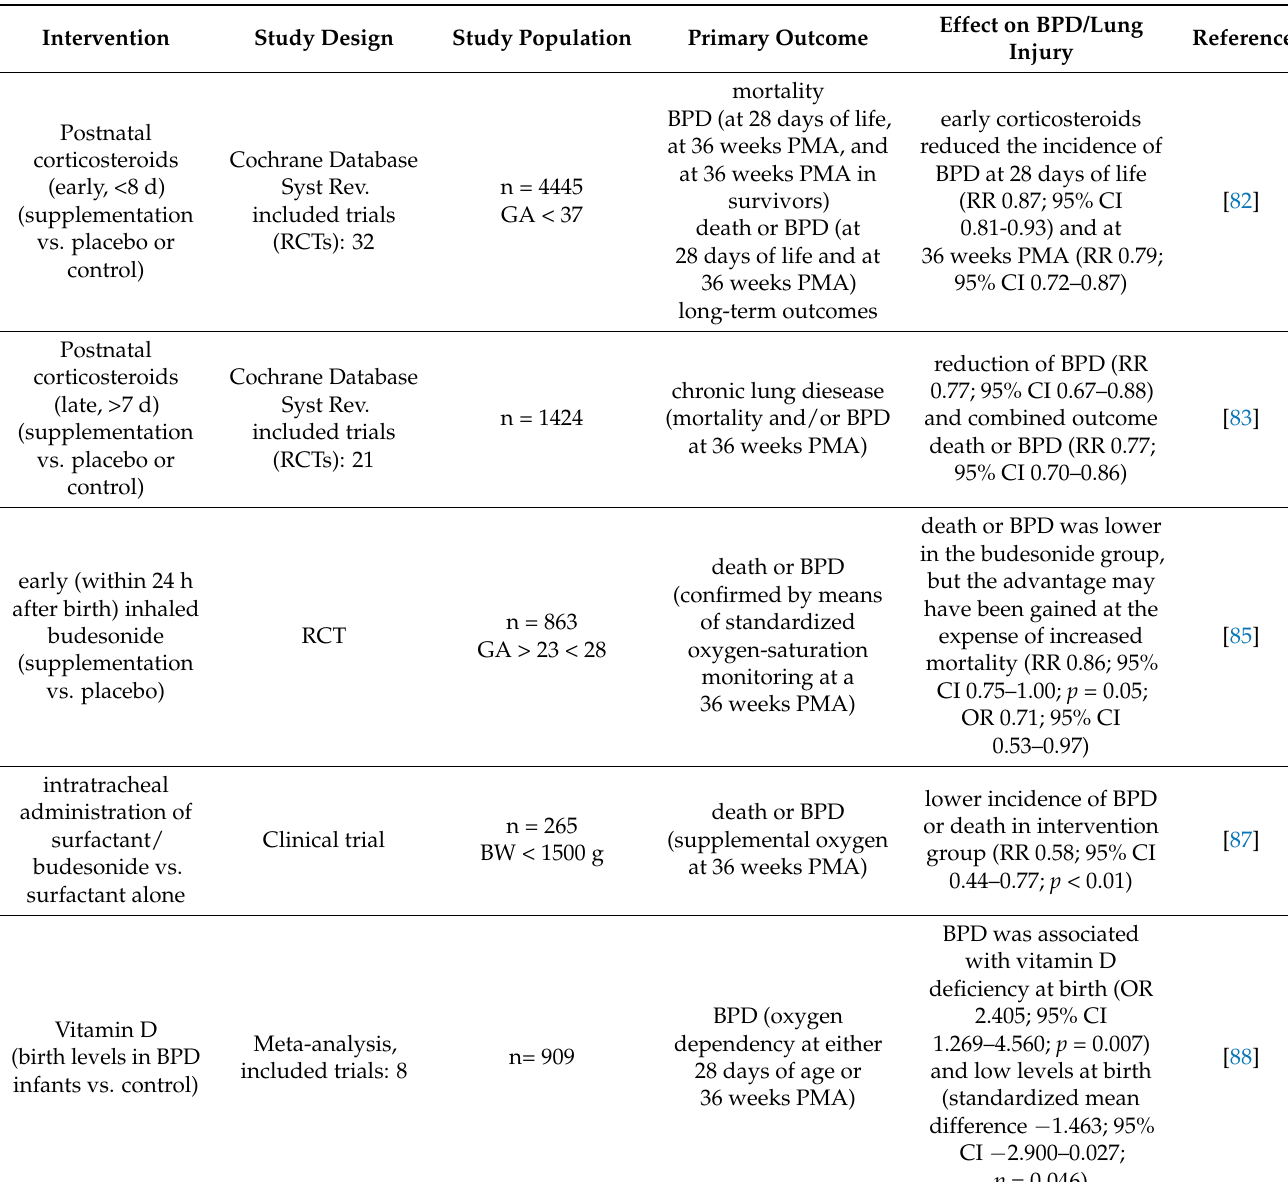
Table 3. Clinical approaches to prevent ROS-induced lung injury and BPD—anti-inflammatory